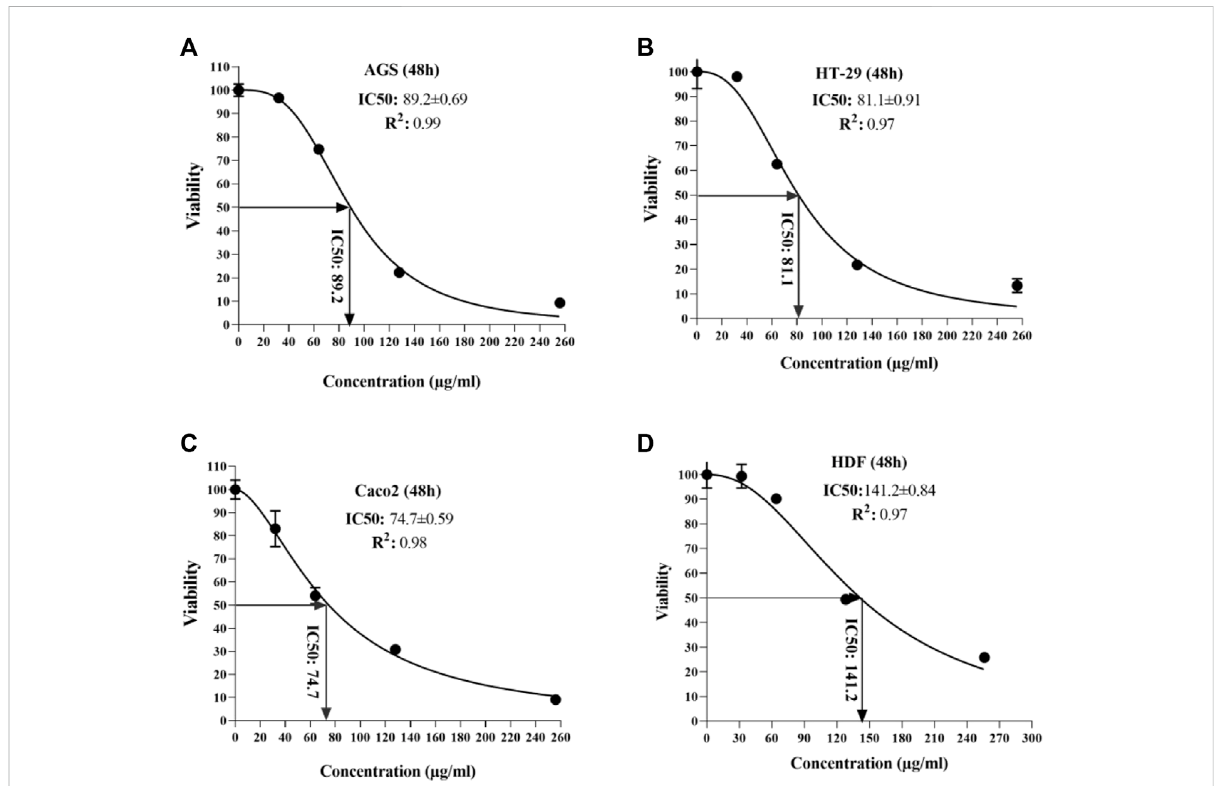
FIGURE 4 Half-maximal inhibitory concentration of T. canis ES TPP in cell lines after 48 h; the highest value was detected in normal cells (141.2) and the lowest in Caco 2 cells